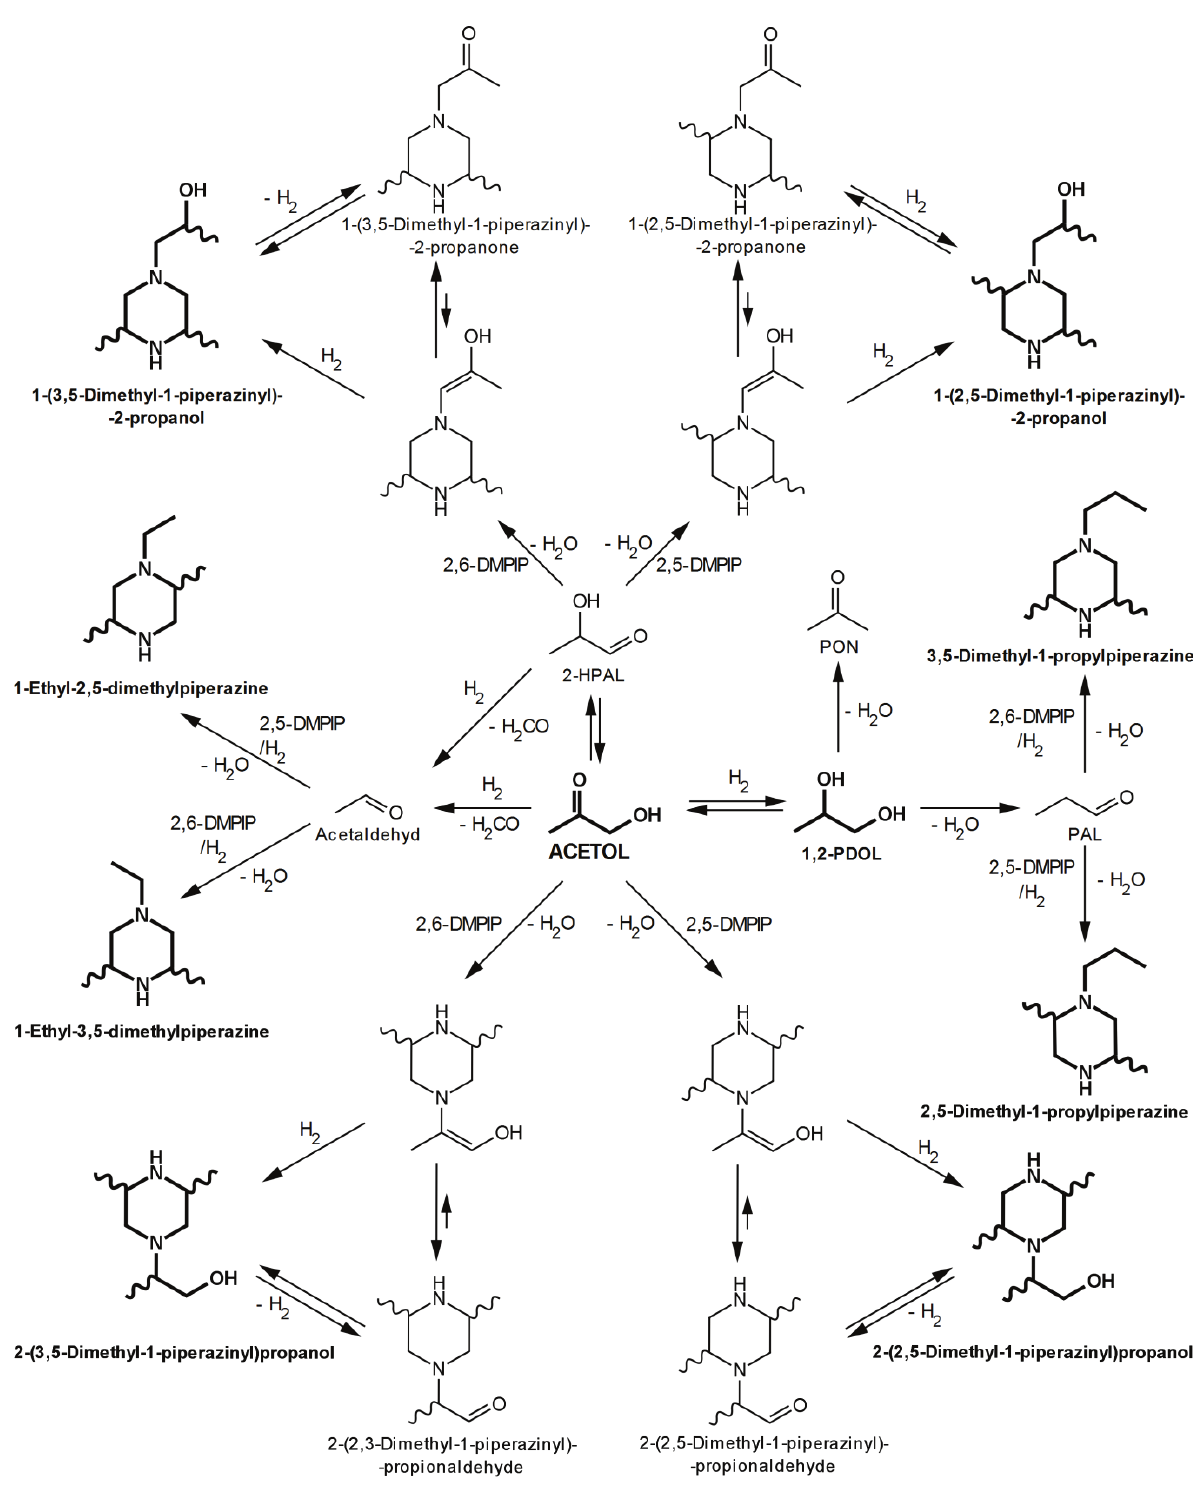
Scheme 8 – Proposed reaction pathways for the formation of identified (bold) N-substituted 2,5- and 2,6-DMPIP during the amination of acetol with ammonia in the presence of Ni-based